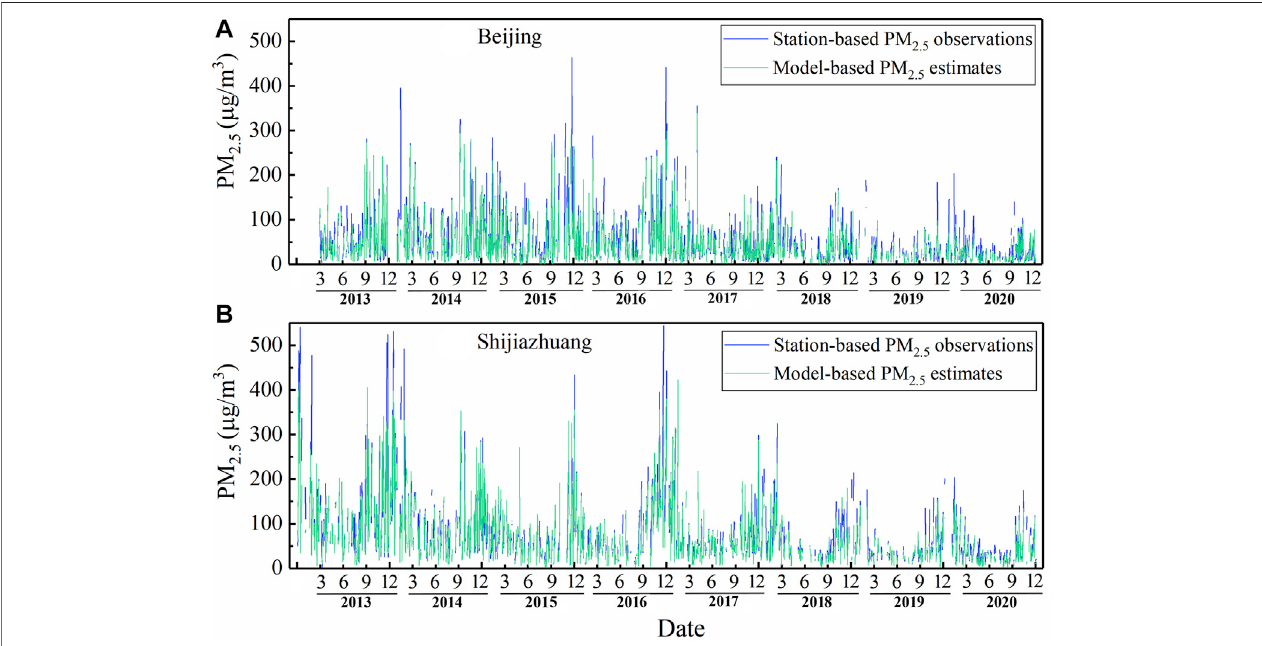
FIGURE 11 | Daily fl uctuation in PM 2.5 concentrations based on station observations and model-based estimates in Beijing (A) and Shijiazhuang (B) .